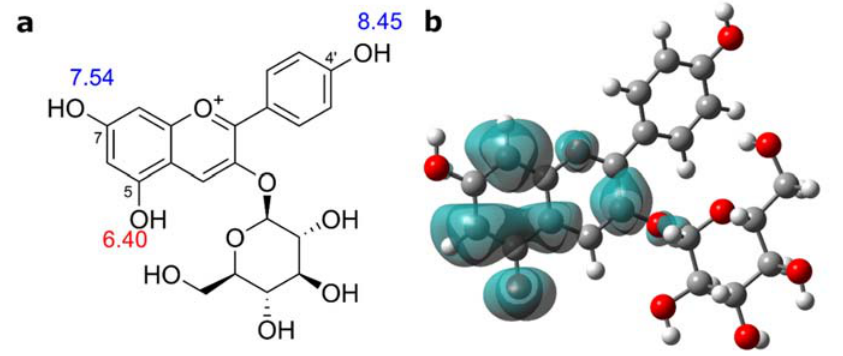
Figure 4. ( a ) Predicted p K a values and ( b ) spin density distribution for 5– O radical of Pg ‐ 3 ‐ glc in water. Table 1. Bond dissociation enthalpy (BDE), ionization potential (IP), proton dissociation enthalpy (PDE), proton affinity (PA), and electron transfer enthalpy (ETE) calculated for the molecular form of pelargonidin ‐ 3 ‐ O ‐ glucoside at M062X/6 ‐ 31+g(d,p) level in the gas phase, and using SMD solva ‐ tion models of water and pentyl ethanoate. All values are given in kJ/mol.